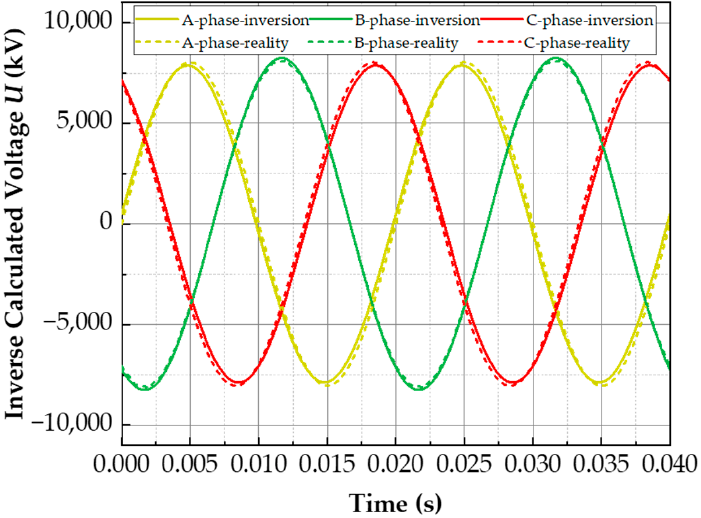
Figure 9. The results of three-point Gaussian–Chebyshev proximal integral inversion at k = 0.9.